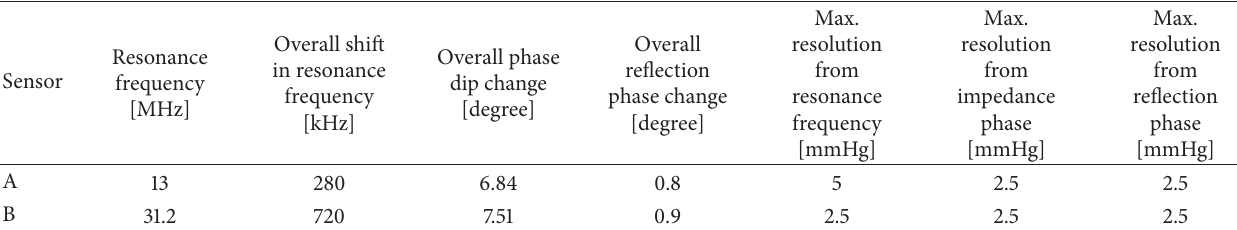
Table 2: Summary of the measurement results.